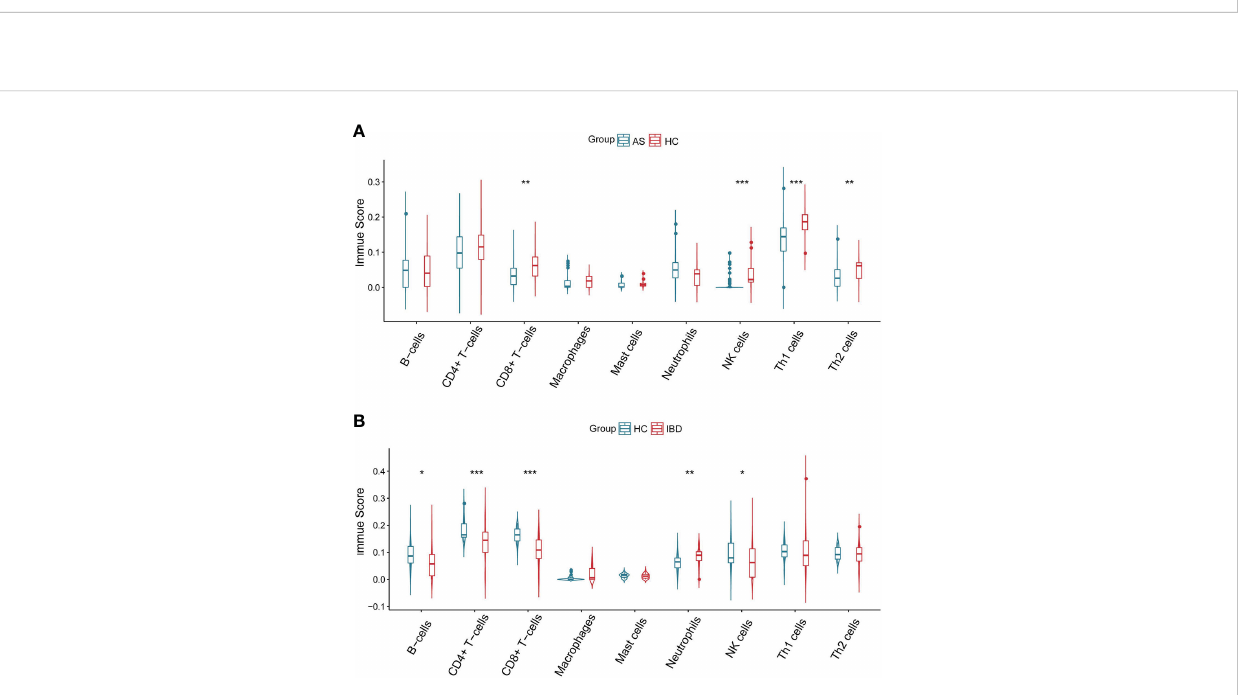
FIGURE 6 Immune scores of immune cells (A) Immune scores of immune cells in AS. (B) Immune scores of immune cells in IBD. *P<0.05 **P<0.01,